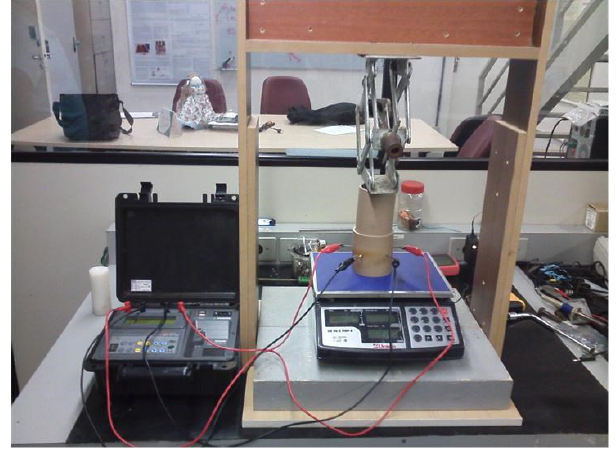
Fig. 8. Apparatus developed for the analysis of correlation R m x C x δ.